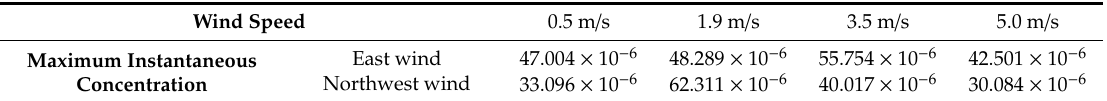
Table 1. Maximum instantaneous concentrations of harmful air near fresh-air intakes under di ff erent wind